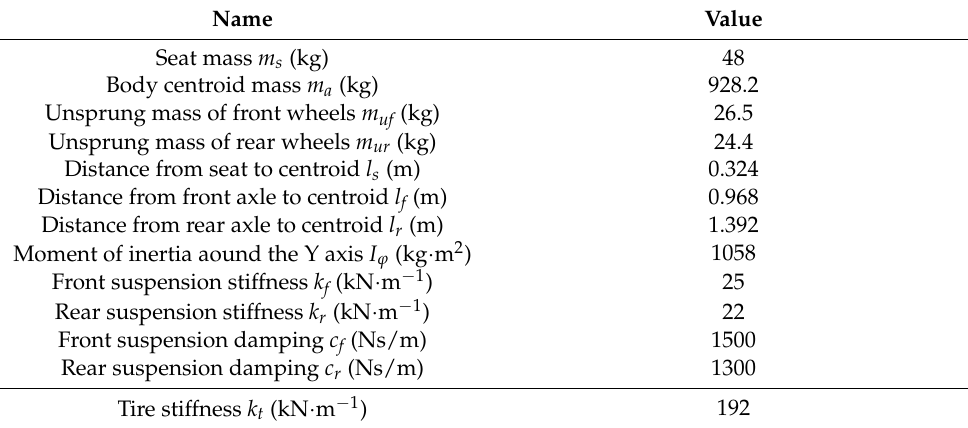
Table 1. Main parameters of the vehicle